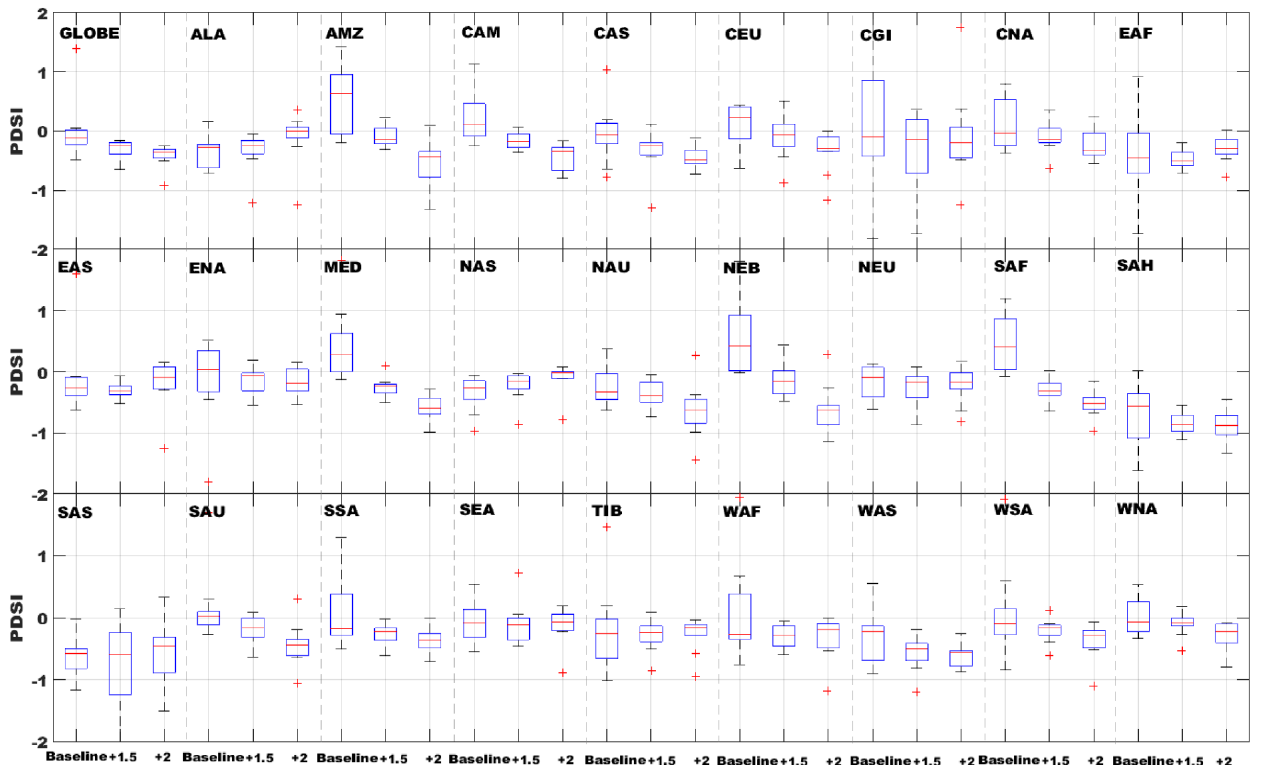
Figure 4. A multi-model projected PDSI globally (66 ◦ N–66 ◦ S) and in 27 world regions for the baseline period and the 1.5 and 2 ◦ C warmer worlds. The projected uncertainty of multiple climate models is shown through box plots for each region and for each